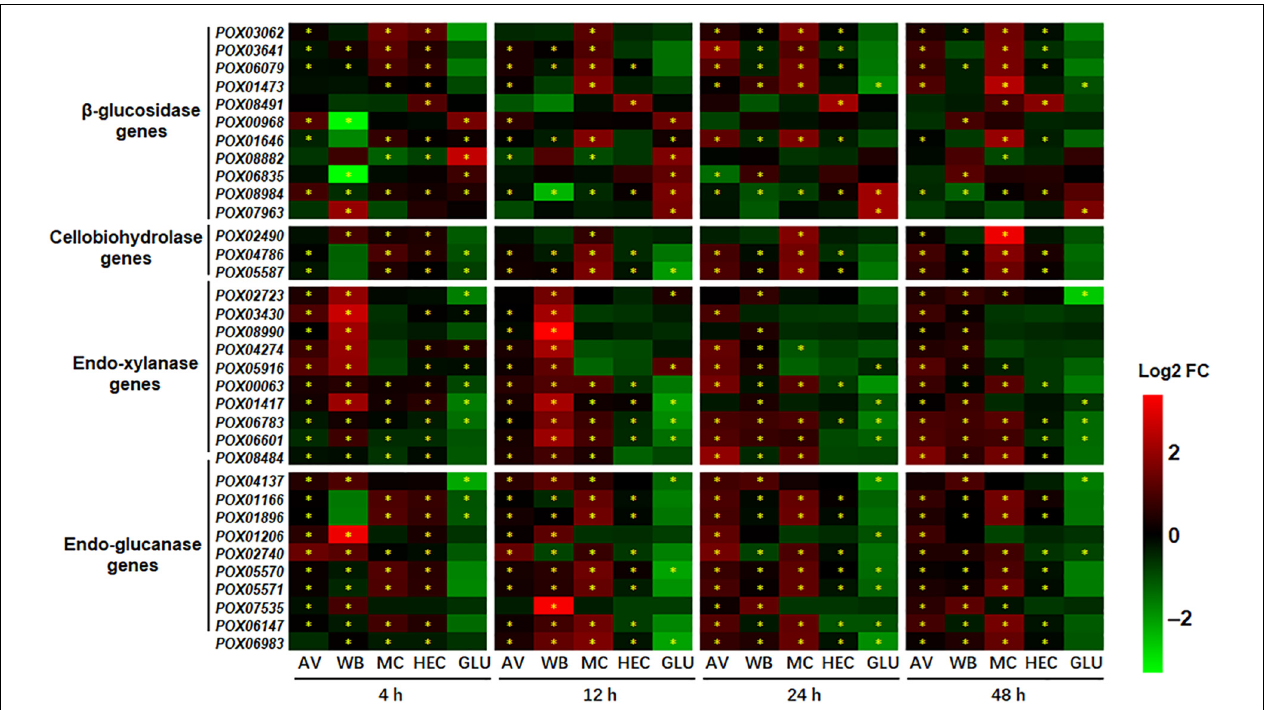
FIGURE 4 | Heatmap indicating transcriptional levels of cellulase and endo-xylanase genes in P. oxalicum on different carbon sources (AV, MC, HEC, WB, and GLU) compared with NC. * represents the DEGs ( p ≤ 0.05, | log2 fold change) | ≥ 1.0). The heatmap shows the log2 fold change of each gene on different carbon sources compared with that on NC. DEGs, differentially expressed genes; AV, Avicel; MC, methyl cellulose; HEC, 2-hydroxyethyl cellulose; GLU, glucose; NC, no carbon source; FC, fold